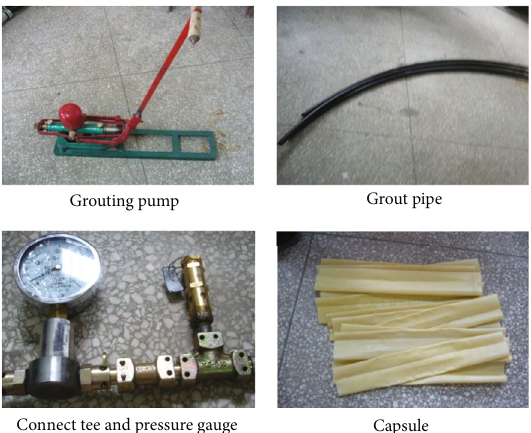
Figure 7: Test main equipment.